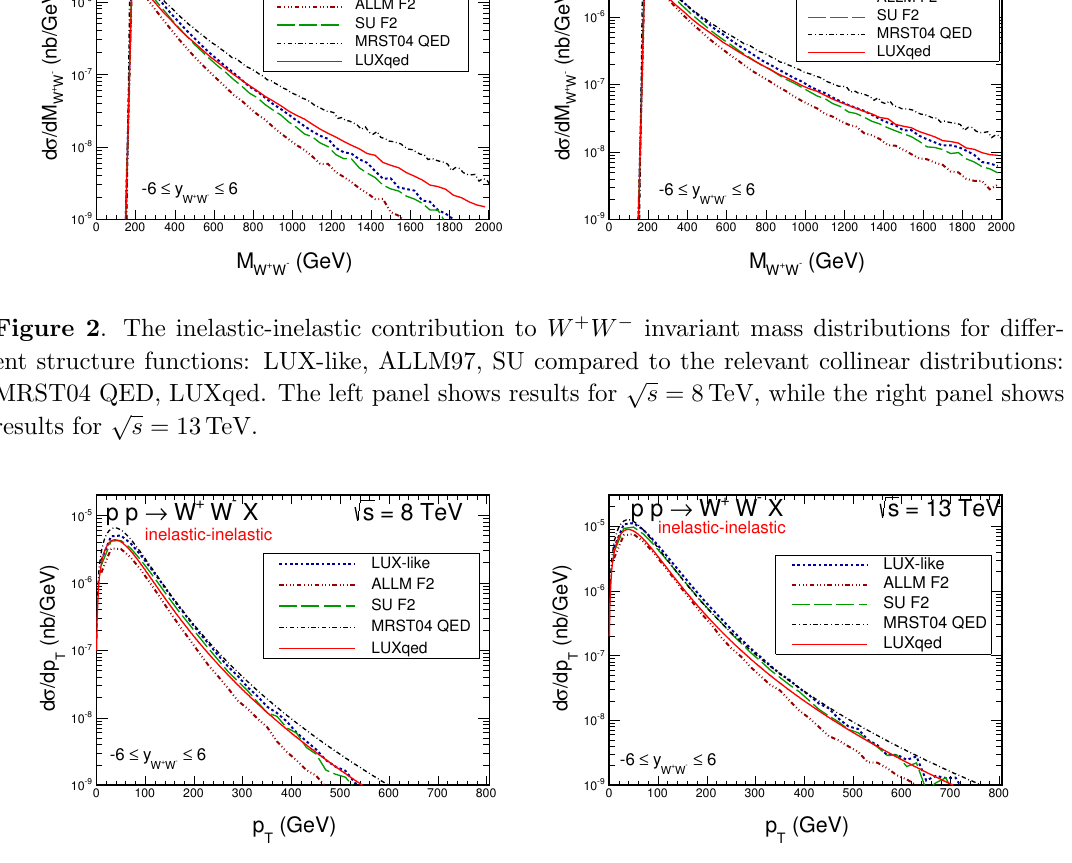
Figure 3 . Transverse momentum distribution of W + or W (cid:0) bosons for di(cid:11)erent structure func- tions: LUX-like, ALLM97, SU compared to the relevant collinear distributions: MRST04 QED, p LUXqed. The left panel shows results for s = 8 TeV, while the right panel shows results for p s = 13